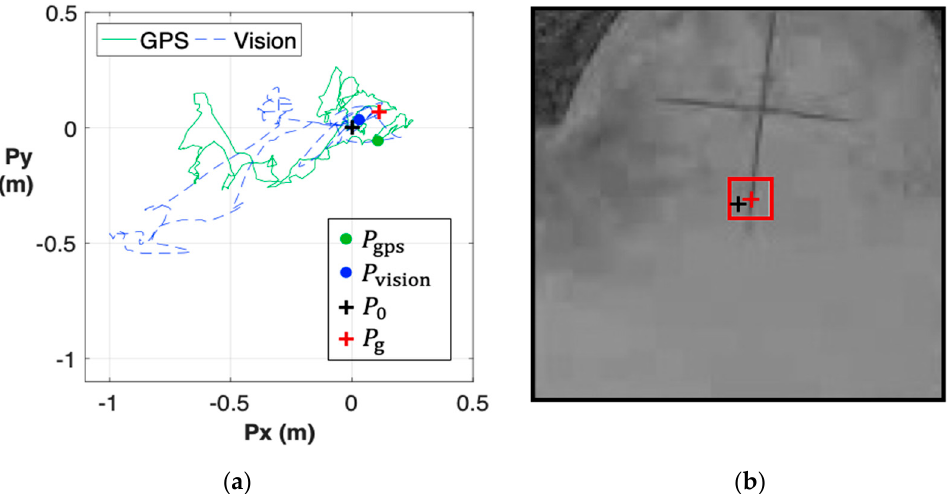
Figure 11. Mode 1 (vision-based landing): ( a ) The in-plane route is obtained from the GPS (green line) and the visual motion estimation system (blue line). The landing process started from the origin (black cross), and was completed at the point marked with a dot; ( b ) The result of template matching shows that the UAV landed approximately 0.1 m away from the designated target.